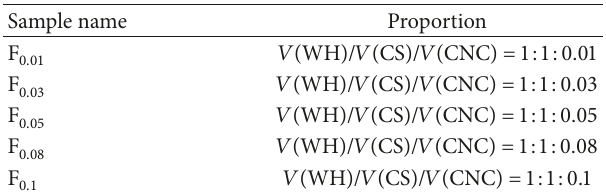
Table 1: The composite films prepared by different volume ratios of WH, CS, and